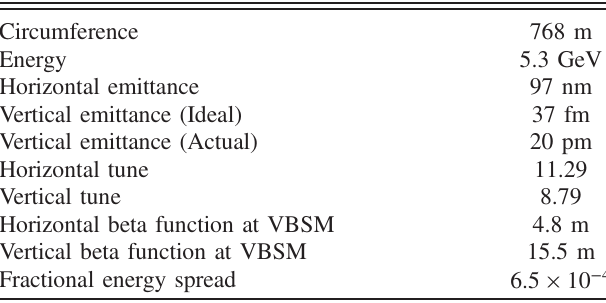
TABLE I. CESR parameters.